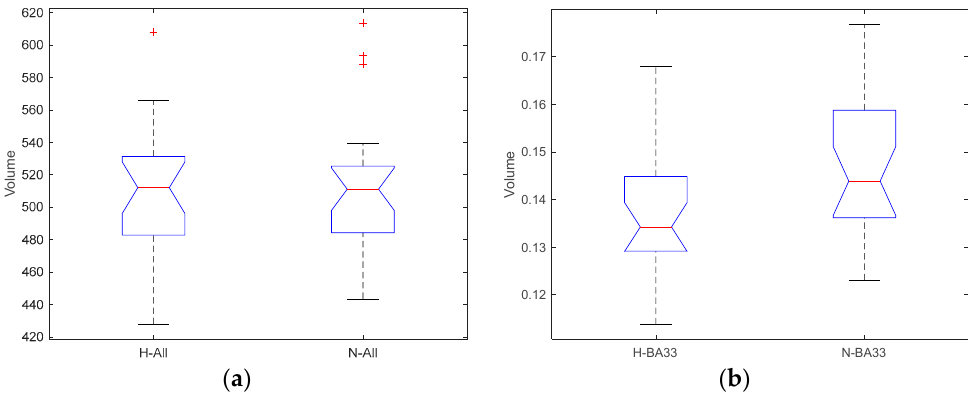
Figure 7. Volume for huffaz and non-huffaz measured in the following VOI: ( a ) whole brain structure and ( b ) Brodmann area 33. The plus signs (+) indicate outliers.